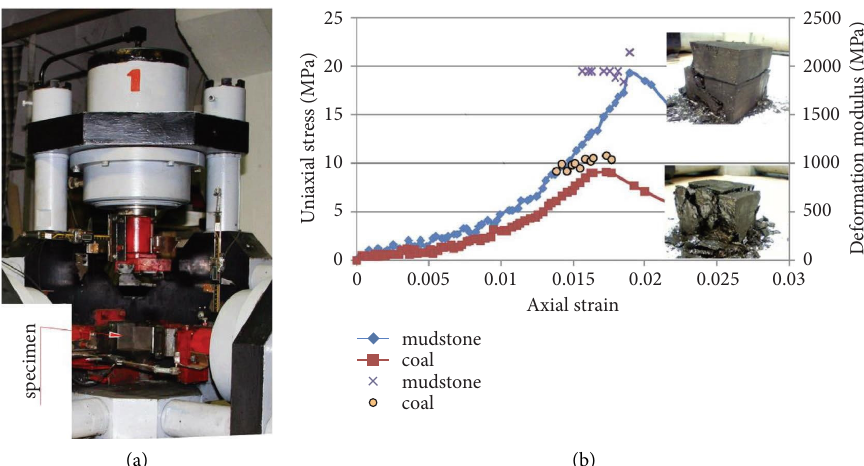
Figure 3: Laboratory equipment and test results: (a) the universal testing machine; (b) stress-strain curve and deformation modulus fuctuations for coal and mudstone